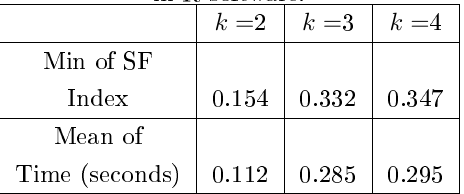
Fig. 4: Sixteen PDFs estimated by sixteen faculties in example 2 before clustering.